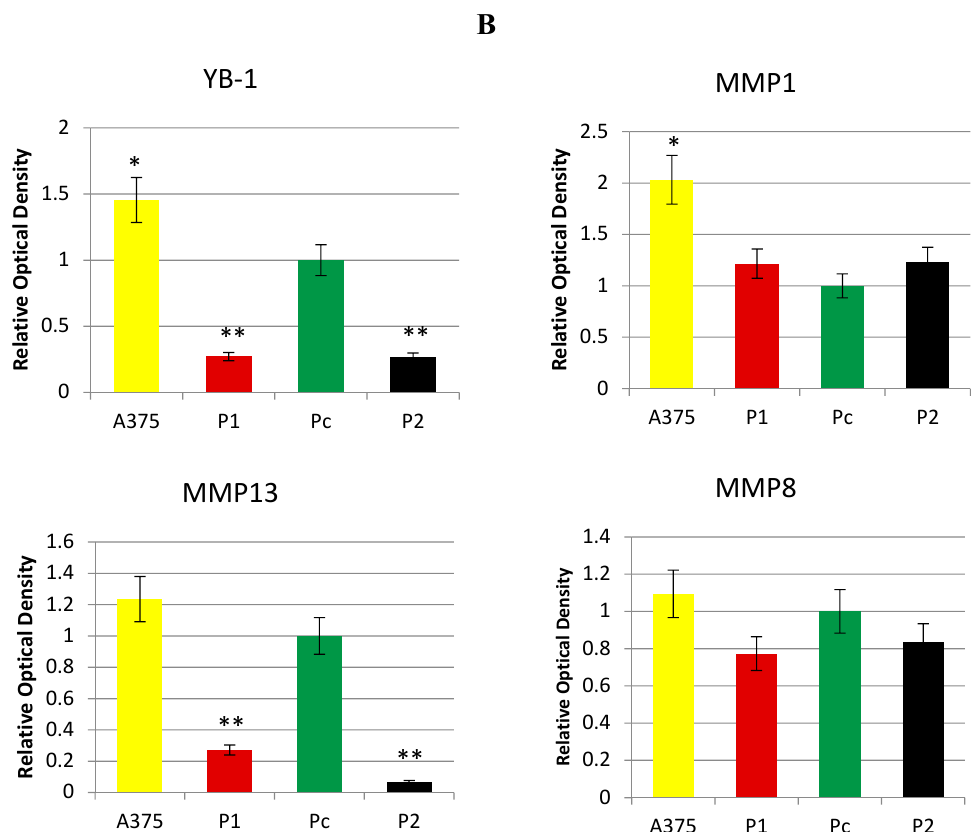
Figure 4. Western blot and densitometry analysis. ( A ) Expression levels of target proteins were assessed by western blotting with alpha-tubulin as an internal control in the selected cell strains. The molecular weight was approximate as follows (MMP1: 54 kDa, MMP8: 53 kDa, MMP13: 54 kDa, YB-1: 45 kDa and TUB: 50 kDa); ( B ) Densitometry analysis by imagJ the quantitative results were expressed as means ± standard error compared with Pc cell strain and analyzed using one-way ANOVA, * p < 0.05, ** p < 0.001.